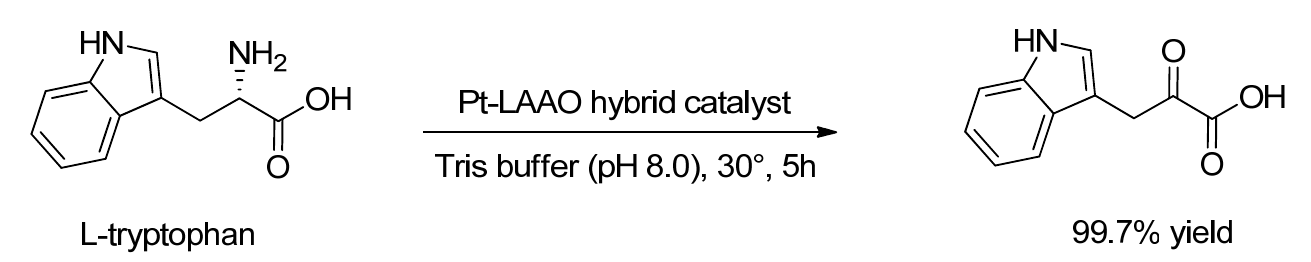
Figure 10. Preparation of a Pt/LAAO catalyst [181]. Reprinted with permission from [181]. Copy- right (2020) American Chemical Society.